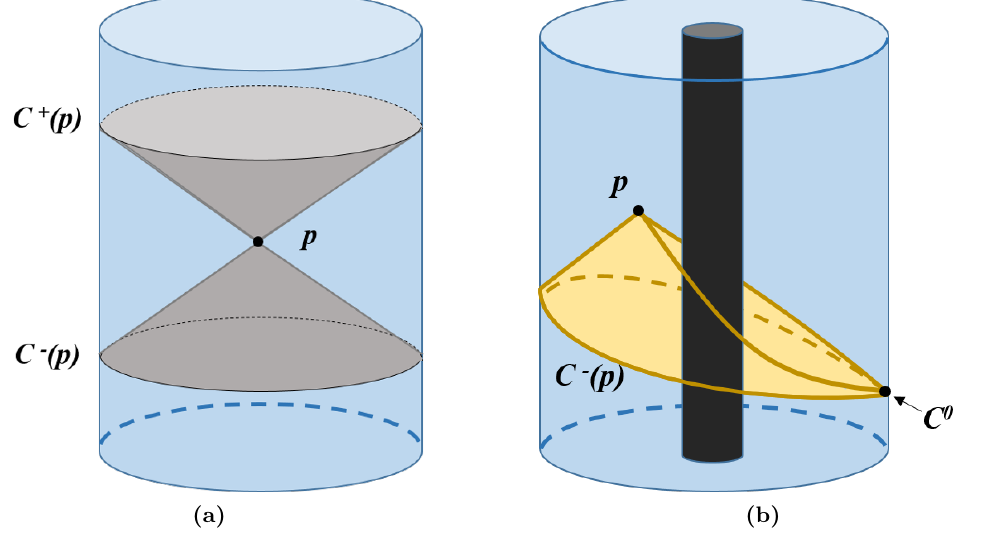
Figure 1. (a) Past and future light-cone cuts for a point p in pure anti-de Sitter geometry. (b) With matter content or a black hole in the bulk, the past light-cone cut C (cid:0) ( p ) is continuous, but fails to be smooth in the cusp created by gravitational